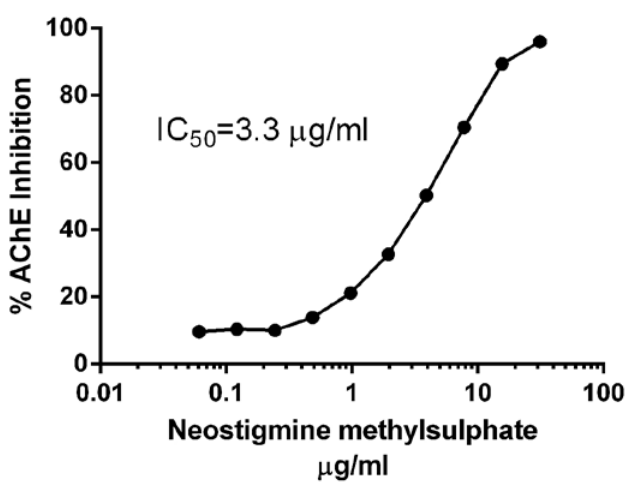
FIGURE 3 - Concentration-dependent effect of the reference AChE inhibitor neostigmine methyl sulphate on AChE enzyme Inhibition. IC of the inhibition was derived using non-linear 50 regression analysis on GraphPad Prism V6.0.